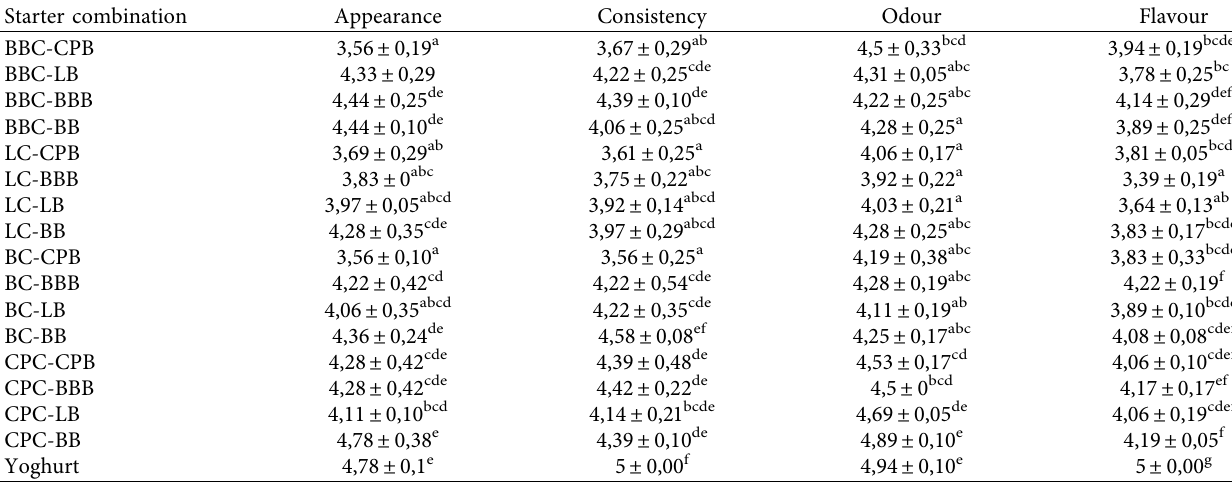
Table 6: Sensory properties (flavour, odour, consistency, and appearance) of yoghurt